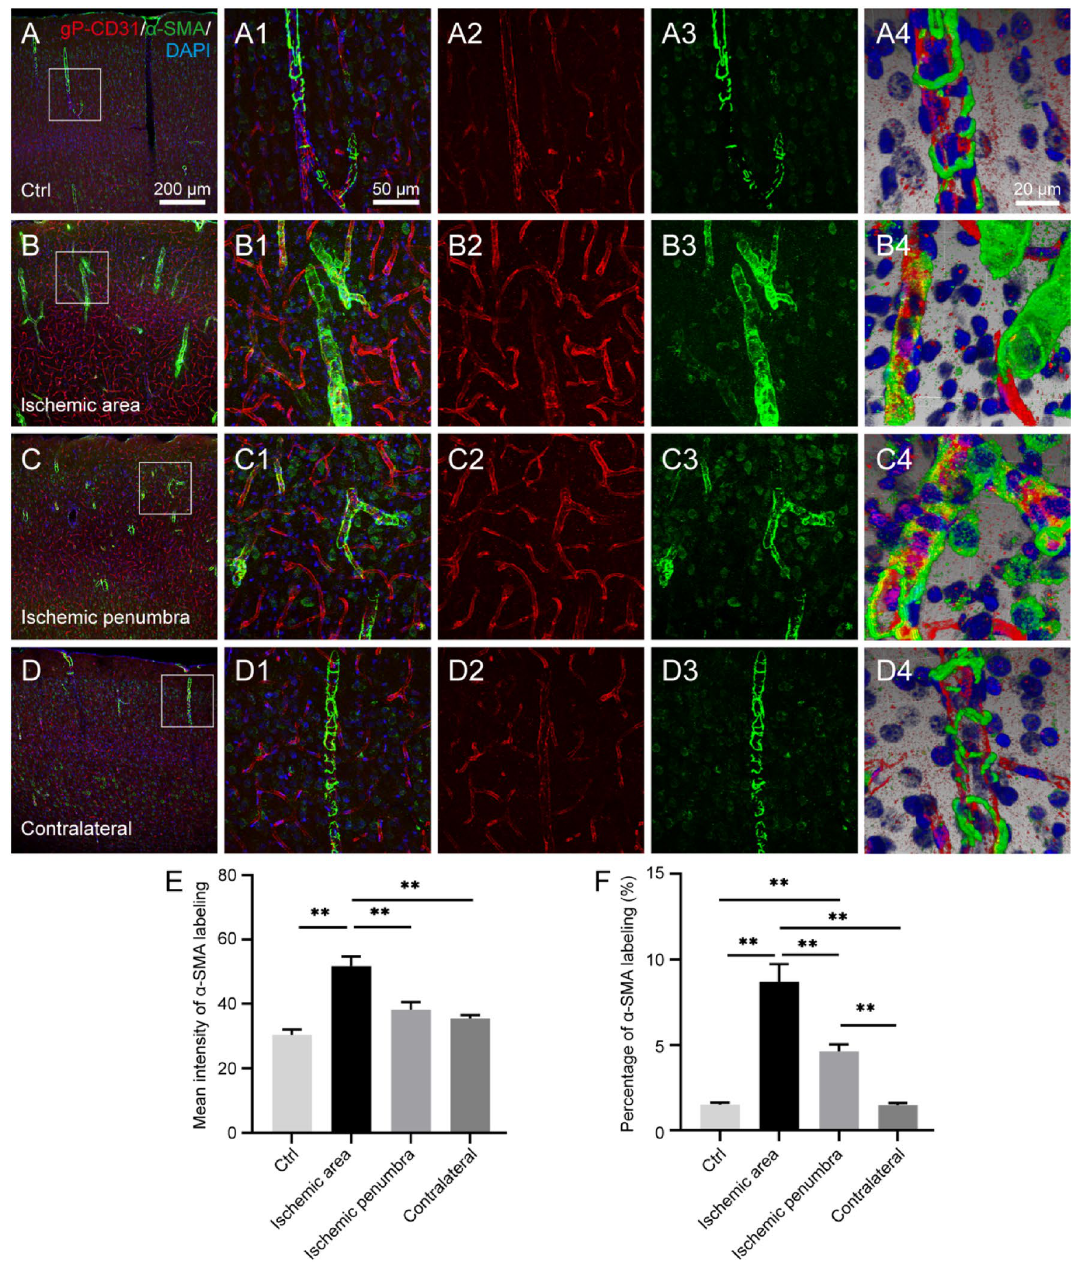
Figure 6. Comparing the distribution of cortical vascular labeling between goat polyclonal anti-CD31 (gP- CD31) and alpha smooth muscle actin (α-SMA) in the healthy and ischemia/reperfusion rat brains. ( A – D ) Representative photographs from the cerebral cortex showing the difference of vascular labeling with gP-CD31 (red) and α-SMA (green), including the normal region ( A ), ischemic region ( B ), ischemic penumbra ( C ), and matching contralateral region ( D ). ( A1 – D1 ), ( A2 – D2 ), ( A3 – D3 ) Corresponding magnified photographs from panels A-D (box-indicated regions) showing the detailed vascular labeling ( A1 – D1 ) separately with gP-CD31 ( A2 – D2 ) and α-SMA ( A3 – D3 ), and further adjusted with three-dimensional reconstruction showing the spatial relationship of vascular labeling with gP-CD31 and α-SMA in detail ( A4 – D4 ). The cellular nucleus was stained by DAPI (blue). ( E , F ) Quantitative analysis of the labeling intensity ( E ) and the percentage ( F ) of α-SMA (n = 4 rats, 12 fields per region, ** P < 0.05). Scale bars: 200 μm in ( A – D ), 50 μm in ( A1 – D1 ), ( A2 – D2 ), ( A3 – D3 ), and 20 μm in ( A4 – D4